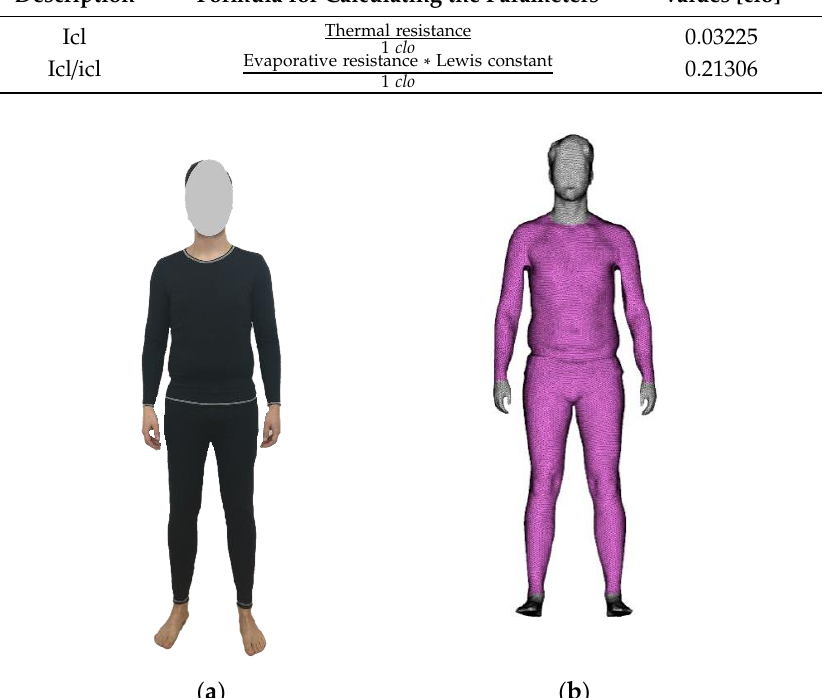
Table 5. Metabolic rate of test person during different levels of activity.